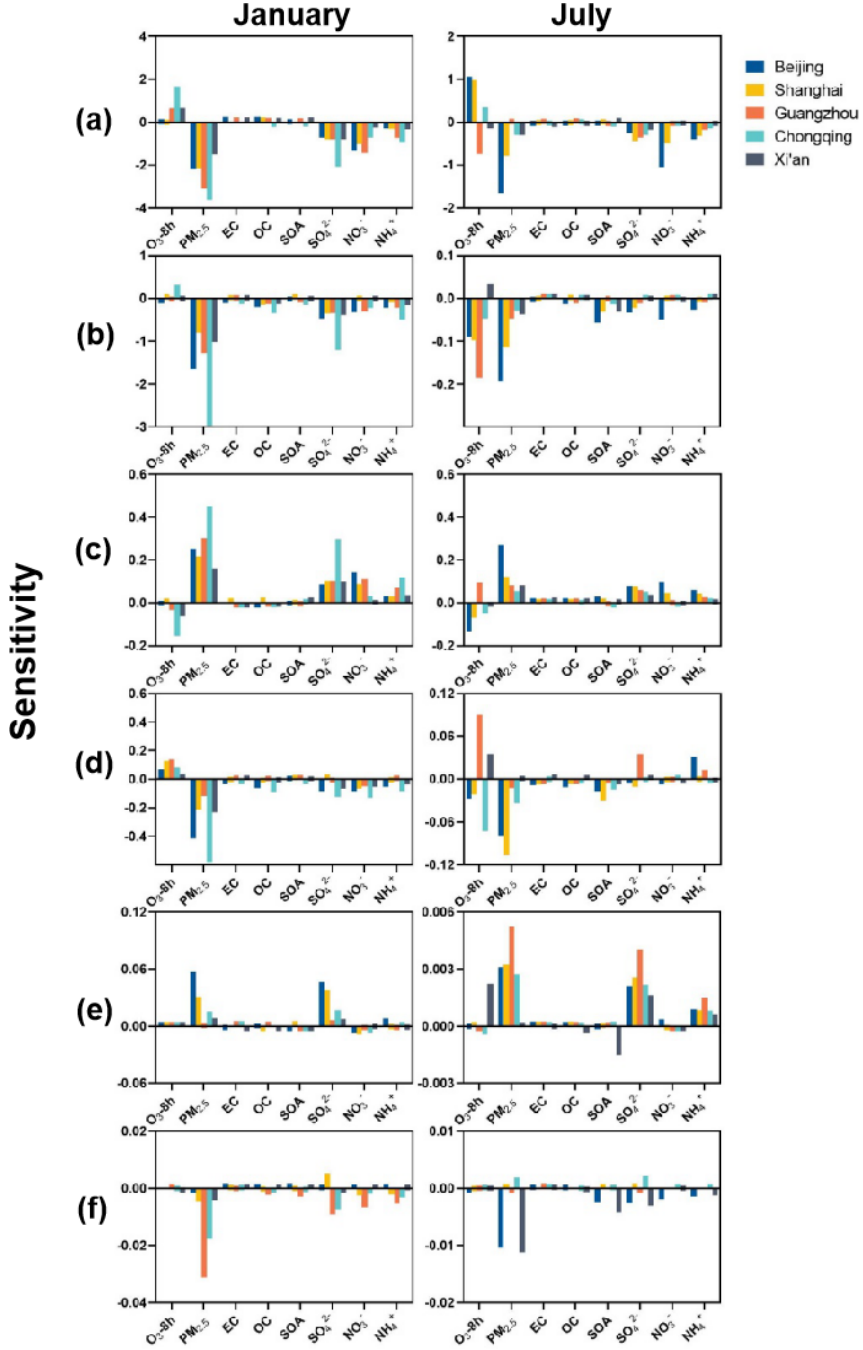
Figure 7. Sensitivity of O 3 -8h, PM 2 . 5 , and its components to the meteorological parameter of (a) T , (b) WS, (c) AH, (d) PBLH, (e) CLW, and (f) PCP in five cities in China. The unit of sensitivity is ppbK − 1 for O 3 -8h to T and is ppb% − 1 for O 3 -8h to other meteorolog- ical parameters; the unit is µgm − 3 K − 1 for PM 2 . 5 and its components to T and is µgm − 3 % − 1 for PM 2 . 5 and its components to other meteorological